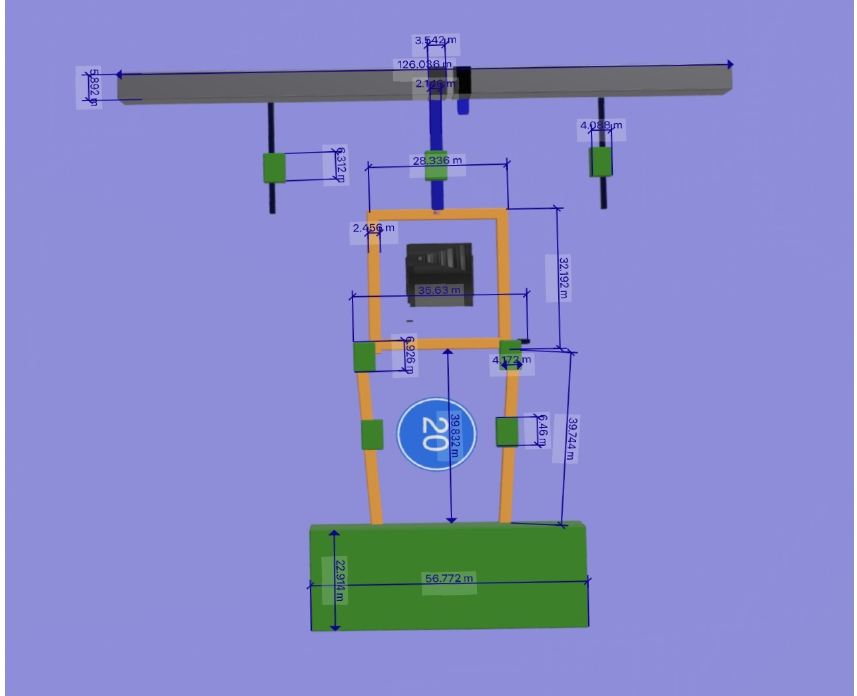
Figure 57. Measurements of the detected facilities of the pyramid. The numbers shown after the comma cannot be significant. (Top-side view).